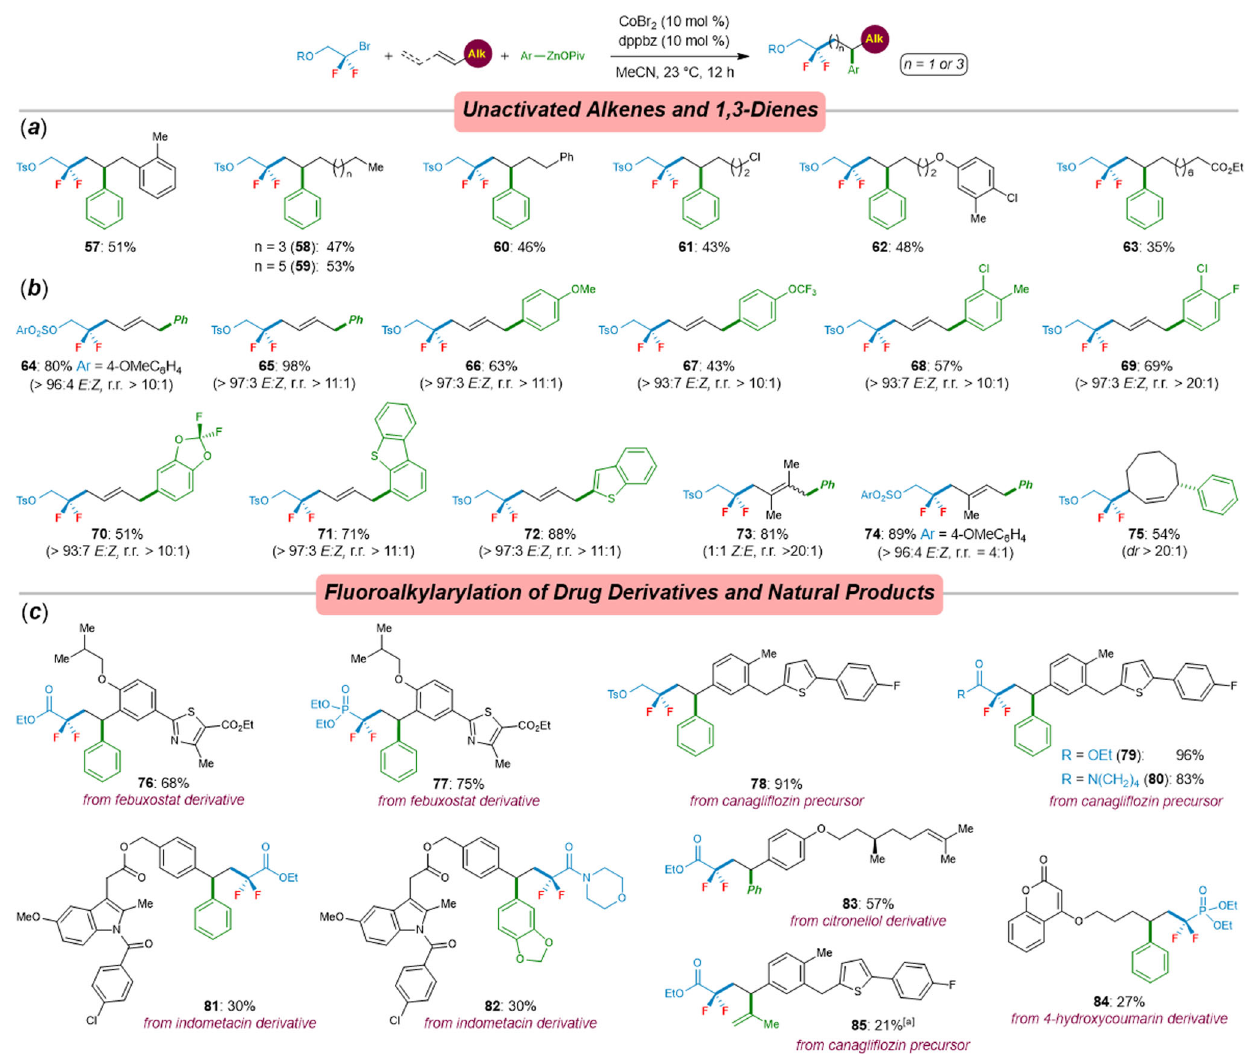
Fig. 4 Di fl uoroalkylarylation of alkenes. a Scope of unactivated alkenes. b Scope of 1,3-dienes. c Late-stage di fl uoroalkylarylation of drug derivatives and natural products. Reaction conditions: 1k (0.25 mmol), unactivated alkenes or 1,3-dienes (0.5 mmol), arylzinc pivalates (0.5 mmol), CoBr 2 (10 mol%), dppbz (10 mol%), and MeCN, 23 °C, 12 h. [a] A second portion of 1a and isopropenylzinc pivalate was